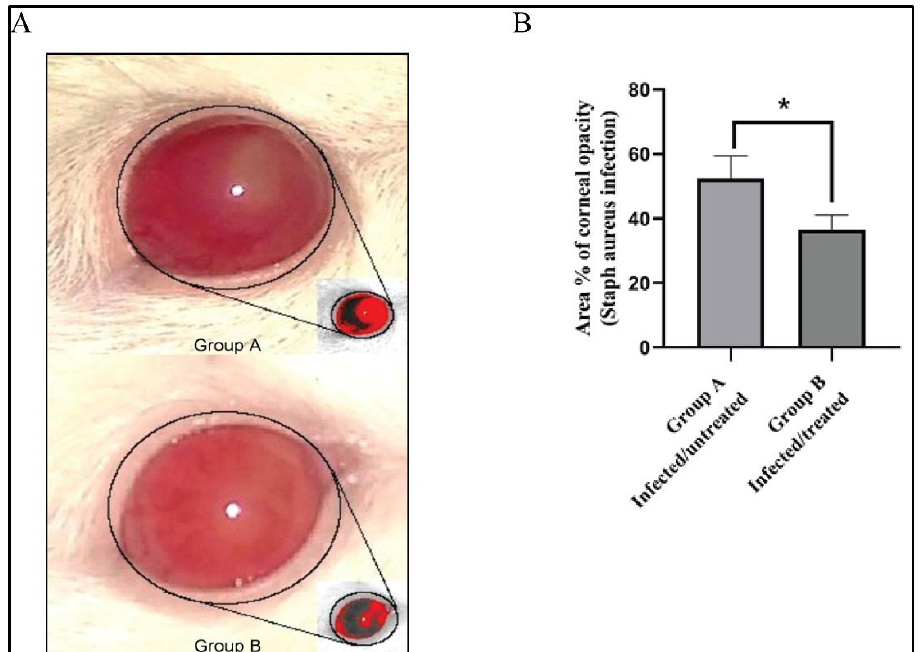
Figure 6. Effect of Bacillus subtilis extract on the % area of corneal opacity. ( A ) Untreated immuno- compromised rats that were infected with MRSA (group A) and immunocompromised rats that were infected with MRSA and treated with Bacillus subtilis BS-40 extract (group B). The red color in the pictures defines the areas with focal lesions (arrows). By using ImageJ, the original images were converted to grayscale, then the opaque areas were segmented using thresholding followed by automatically measuring the thresholded area. ( B ) Quantification of the effect of Bacillus subtilis BS-40 extract on the % area of corneal opacity on untreated immunocompromised rats that were infected with MRSA (a) and immunocompromised rats that were infected with MRSA and treated with Bacillus subtilis BS-40 extract (b). * vs. group A (infected/untreated).